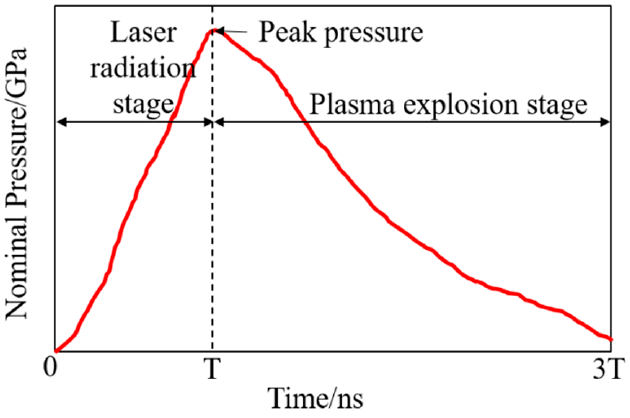
Figure 2. Schematic diagram of time course of the shock wave pressure .